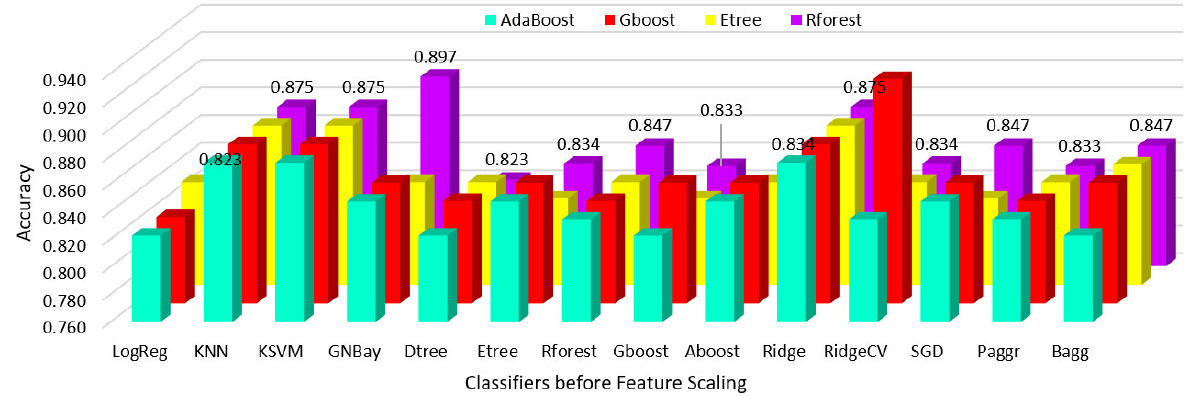
Figure 9. Classifier feature importance performance of all classifiers before scaling.